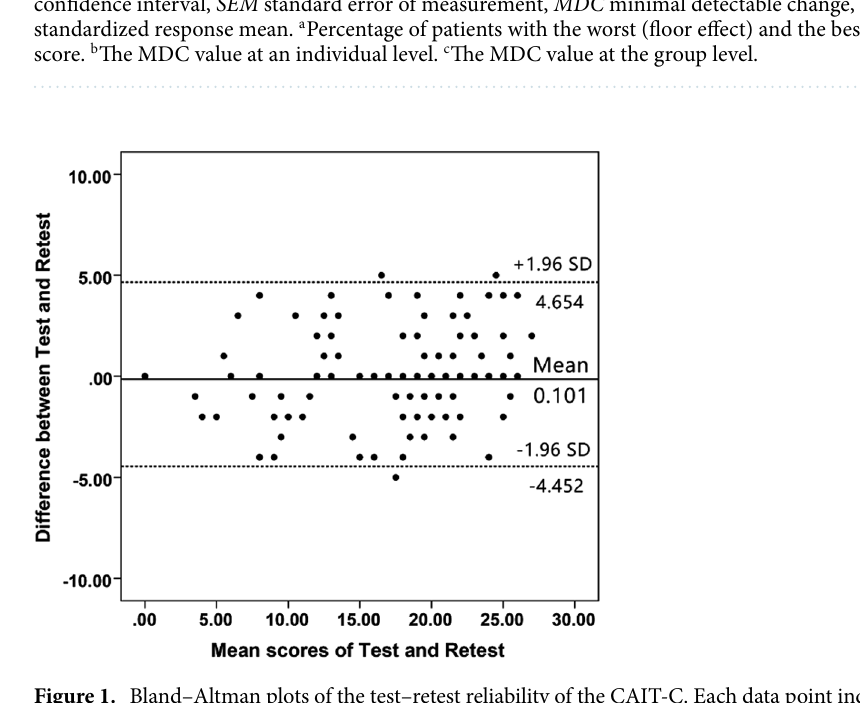
Figure 1. Bland–Altman plots of the test–retest reliability of the CAIT-C. Each data point indicates how the difference between the two test sessions for an individual patient compares to the mean of the two sessions for scores of each CAIT-C. The interval of two sessions was 1 week. The dashed line shows the 95% (± 1.96 SD) limits of